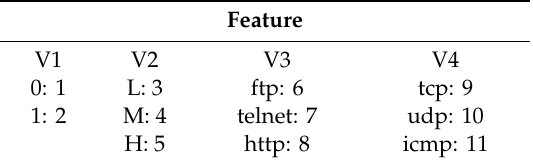
Table 3. Coding scheme for assigning values to categorical features.